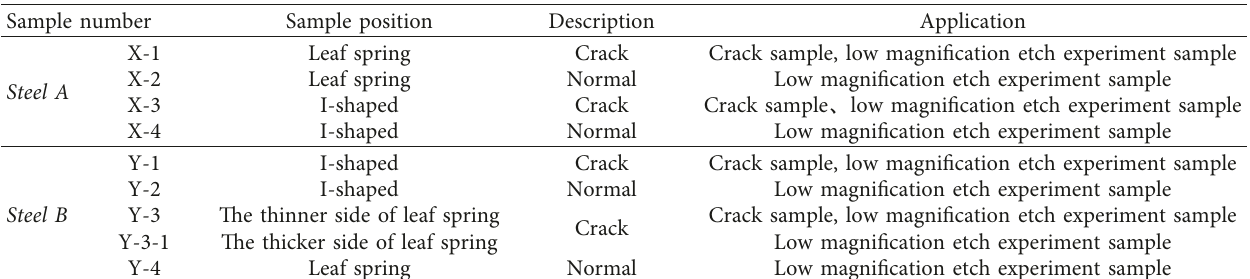
Figure 3: The front axle components of Steel B. Table 2: Sample type, position, and